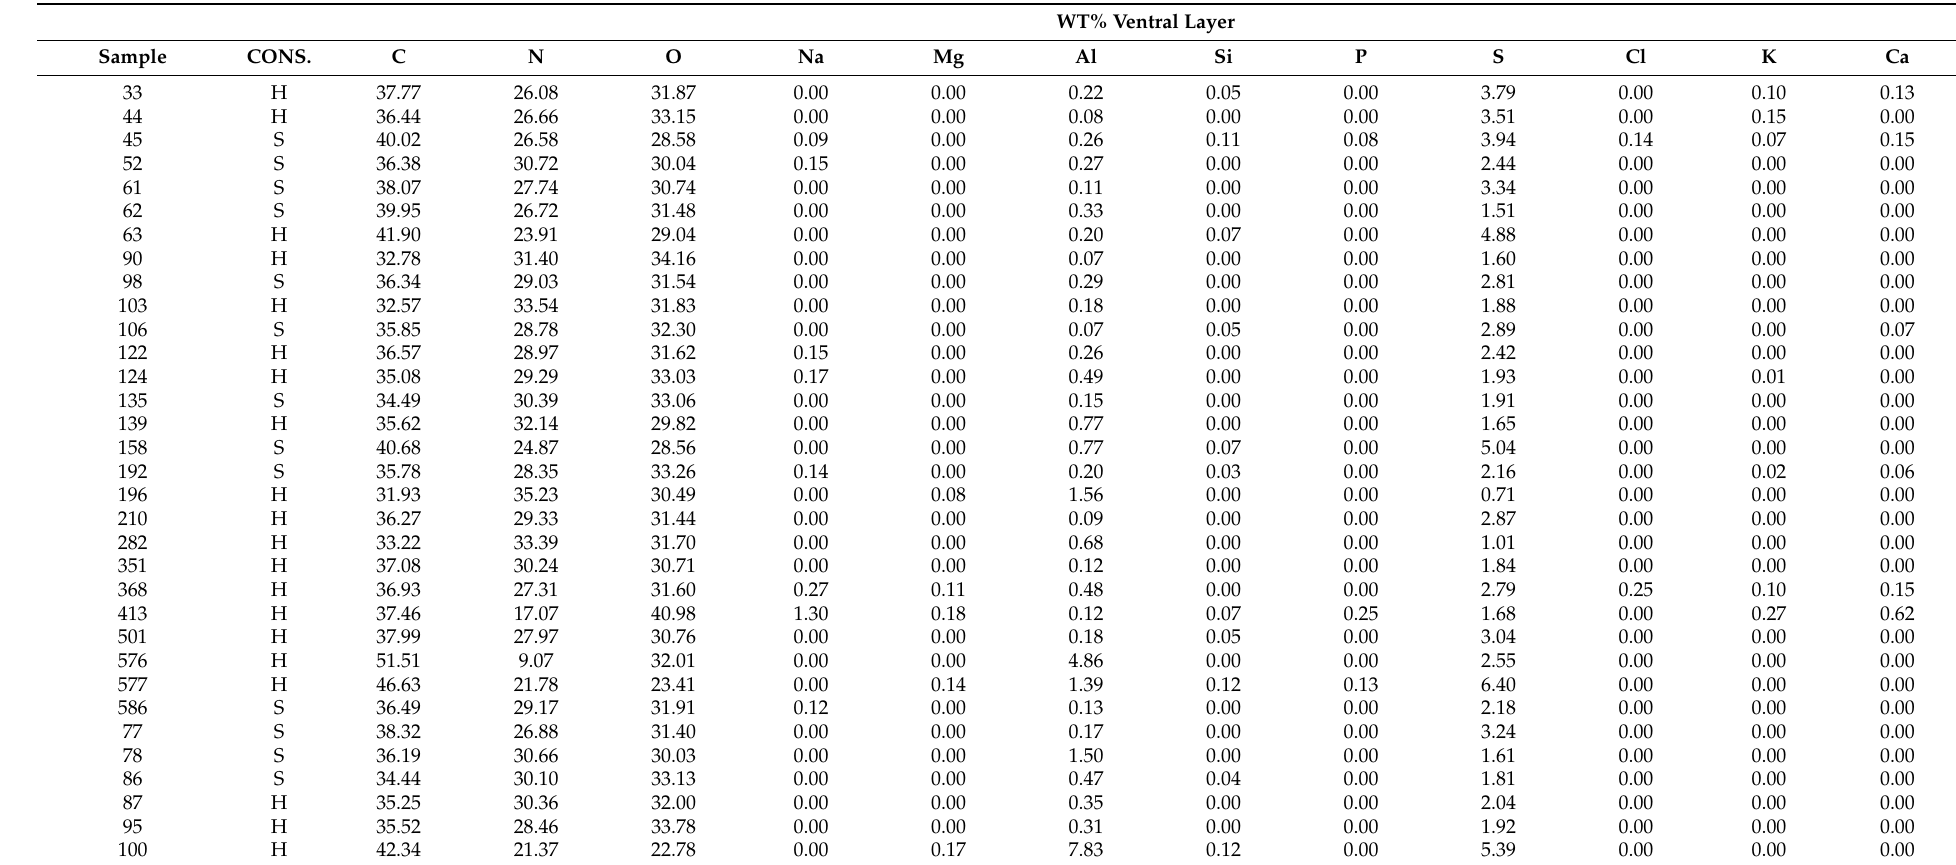
Table 4. WT% values of elements in the ventral layer. WT%, weight percentage; CONS, consistency; C, carbon; N, nitrogen; O, oxygen; Na, sodium; Mg, magnesium; Al, aluminium; Si, silicon; P, phosphorus; S, sulphur; Cl, chloride; K, potassium; Ca, calcium; H, hard; S, soft; SD, standard deviation. WT% Ventral